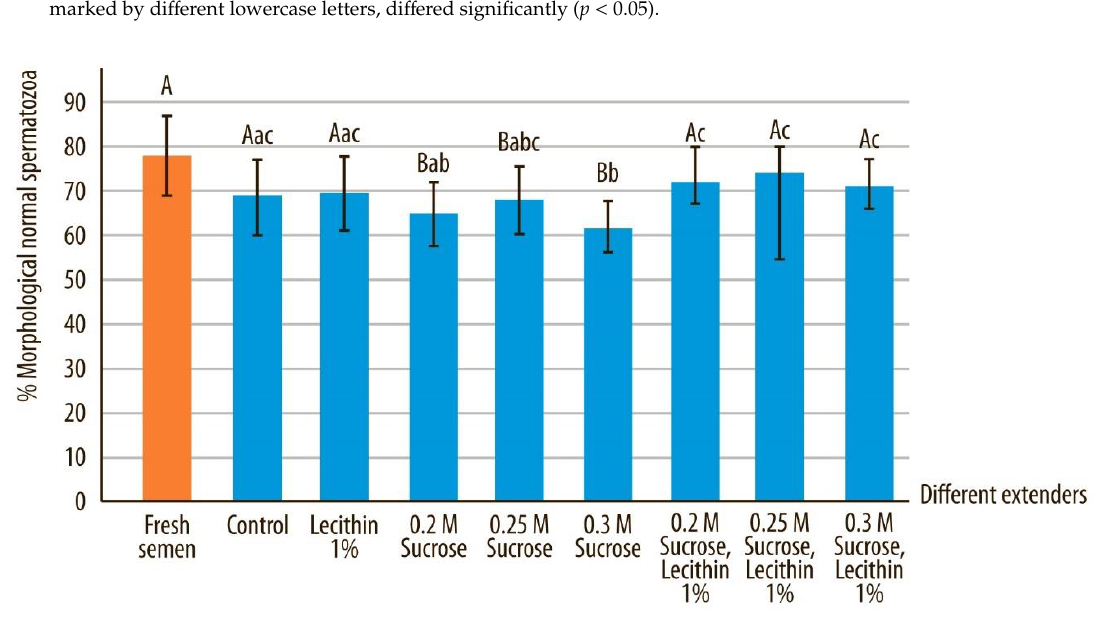
Table 2. Different types of morphological abnormalities in different extenders expressed as mean ± SD.